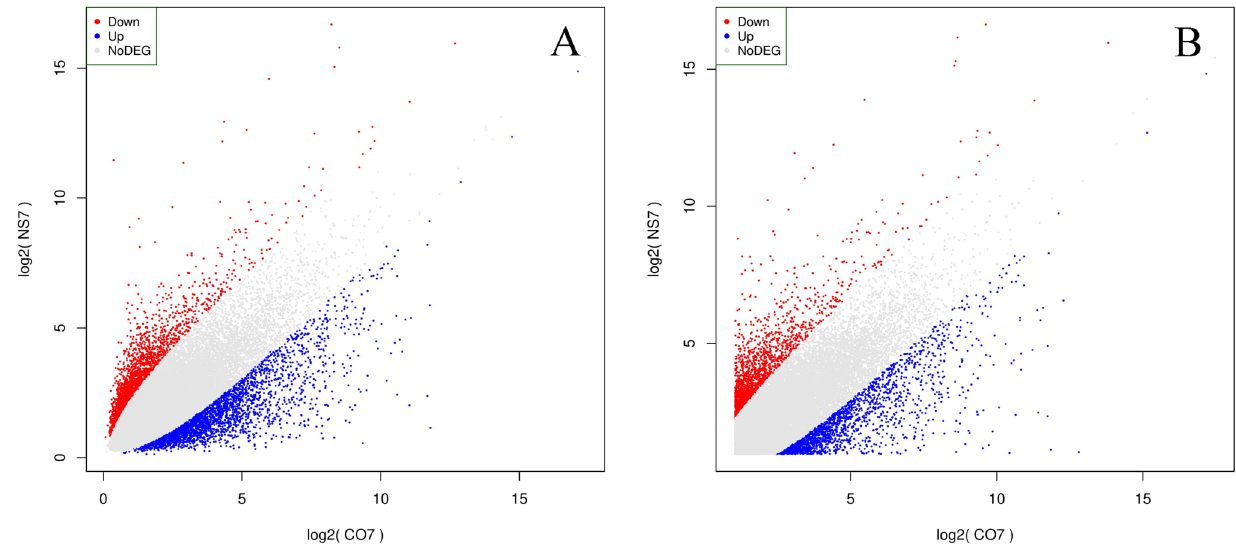
Figure 7. Scatter-plot displaying differentially expressed isoforms ( A ) and unigenes ( B ).